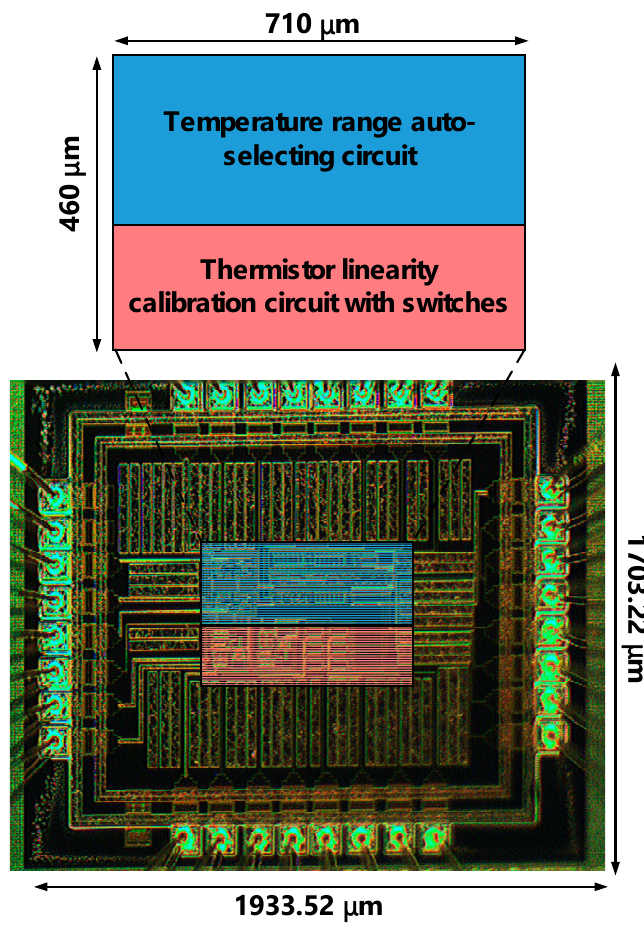
Figure 8. Die photo of the proposed temperature sensor.